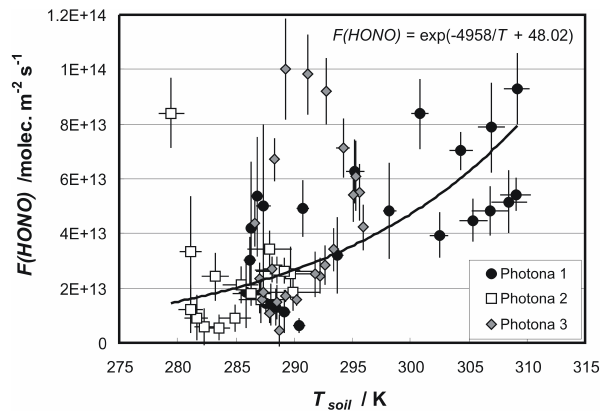
Figure 6. Average diurnal HONO fluxes of all individual campaigns as a function of the soil temperature. The black line presents the regression fit using the exponential function F (HONO) = exp( (cid:49) sol H /RT soil + C), where R is the universal gas constant (8.314Jmol 1 K − 1 ) and (cid:49) sol H is the experimental en- thalpy of solvation ( − 41.2kJmol − 1